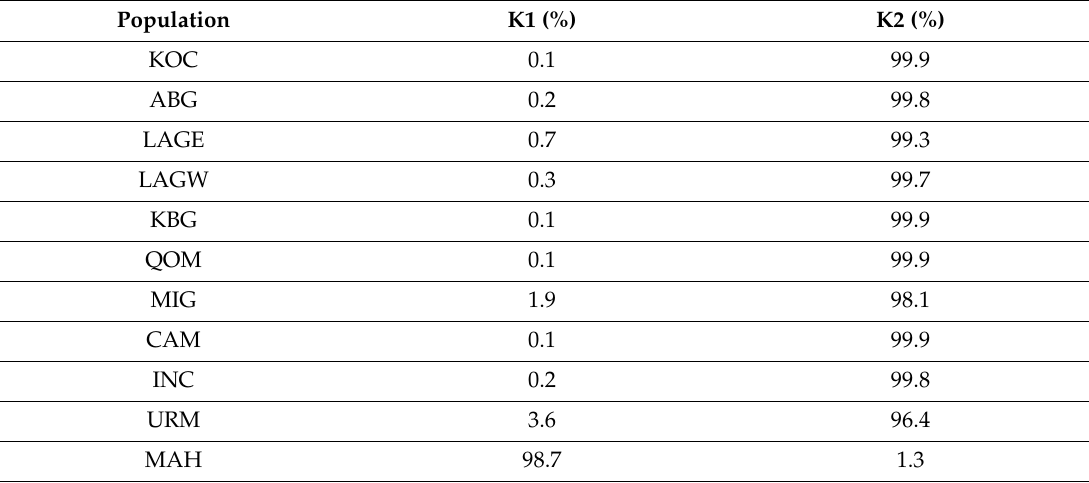
Table A3. Proportion of genetic clusters for each locality in STRUCTURE analysis among whole examined